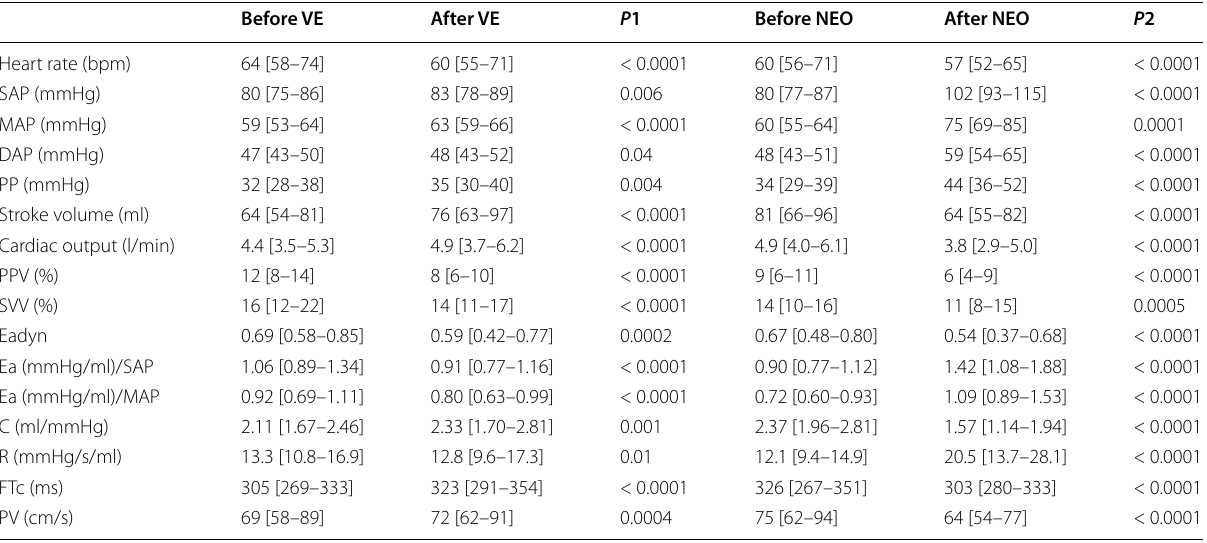
Values are median [percentile, 25–75]